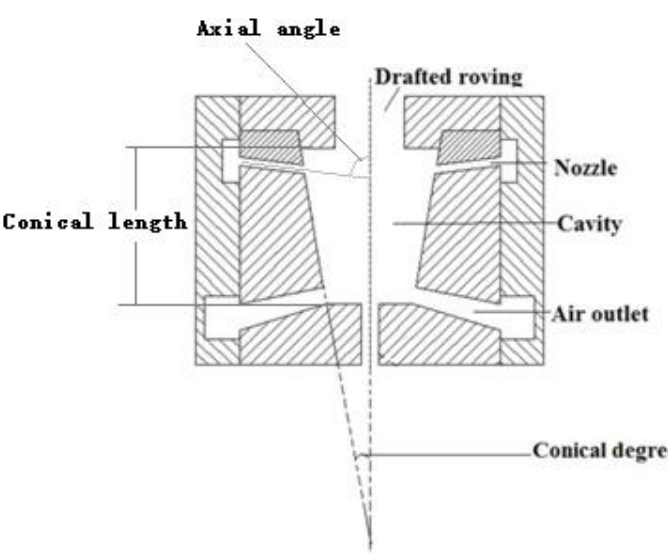
Figure 2. Cross-sectional view of the pre-twister.